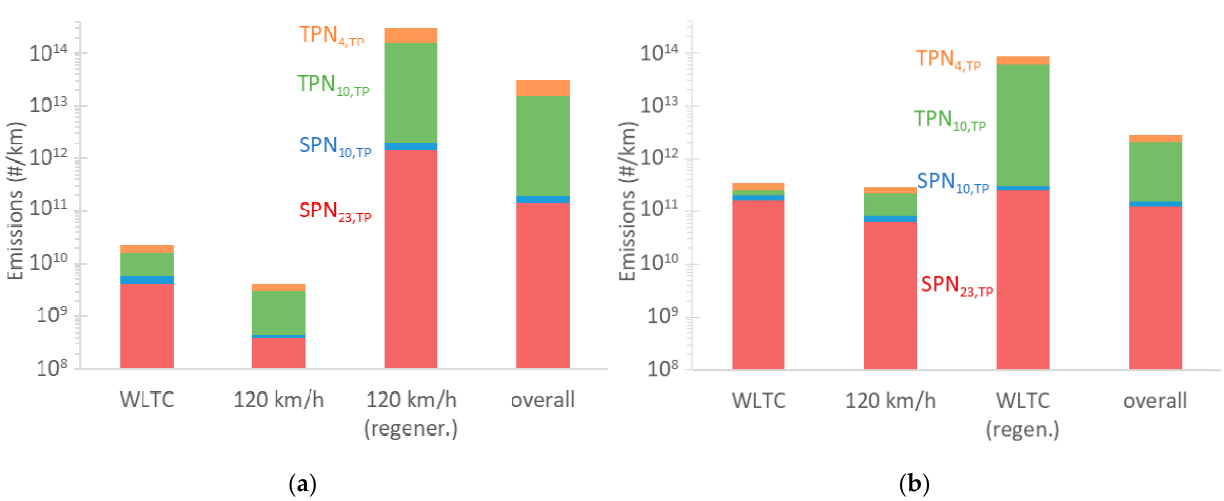
Figure 9. Solid particle number (SPN) and total particle number (TPN) emissions measured from the tailpipe with counters of different lower cut-points. The results are plotted separately for the worldwide harmonized light vehicles test cycle (WLTC) and 120 km/h, without and with active regeneration, and the overall (i.e., weighted with one regeneration event) emissions: ( a ) Vehicle #1 (Euro 6d-Temp); ( b ) Vehicle #2 (Euro 6b).